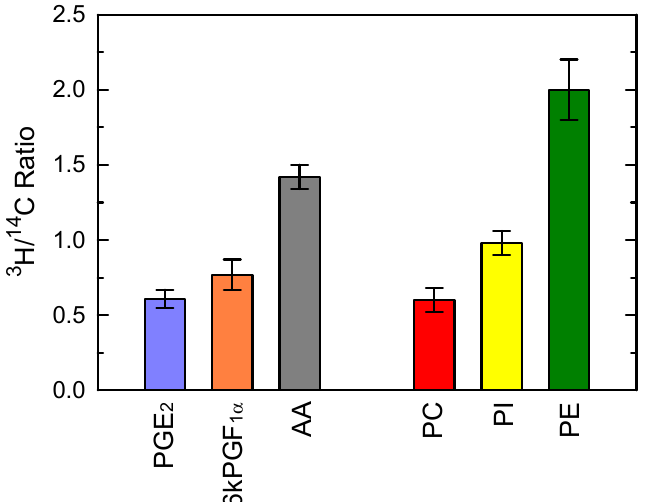
Figure 4. Phospholipid sources of prostaglandins produced by zymosan-stimulated macrophages. The cells, labeled with both [ 3 H]AA and [ 14 C]AA were treated with 1 mg/mL zymosan for 1 h. Afterward, the 3 H/ 14 C ratio of extracellularly liberated PGE 2 , 6-keto-PGF 1 α and AA was calculated. The 3 H/ 14 C ratio for AA-containing PC, PI and PE is shown for comparison.